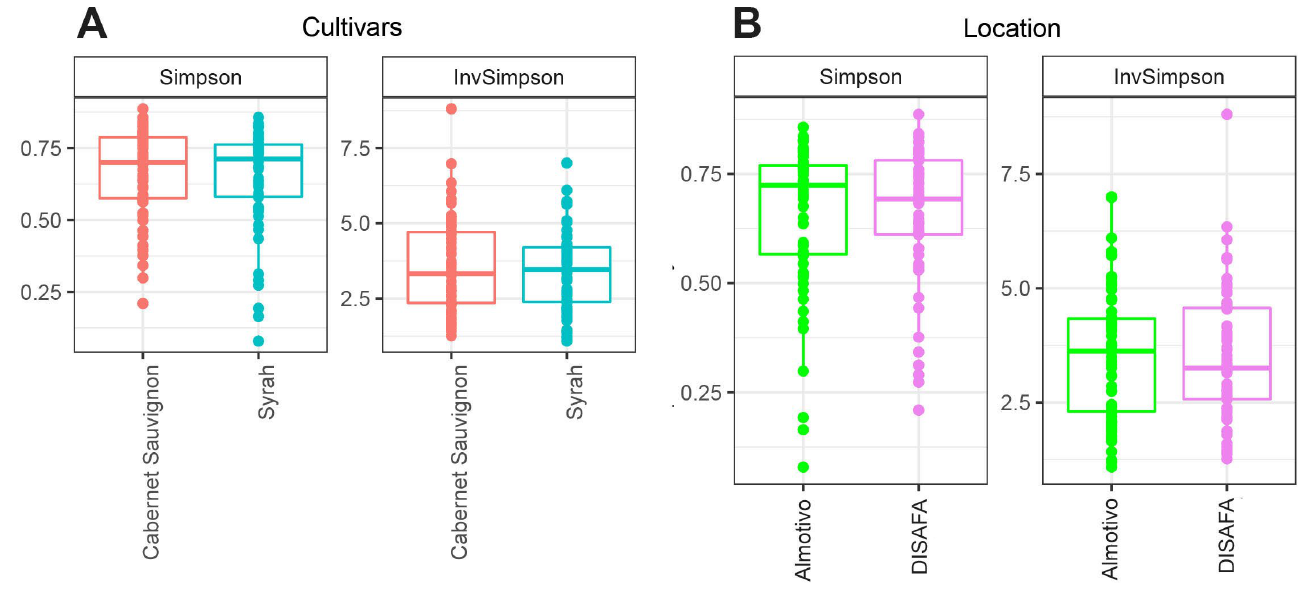
Figure 2. Box plots of alpha diversity indices (Simpson and InvSimpson) of the fungal communities in canes when analyzed by cultivar (Cabernet Sauvignon, Syrah; ( A )) or vineyard (Almotivo, DISAFA; ( B )).